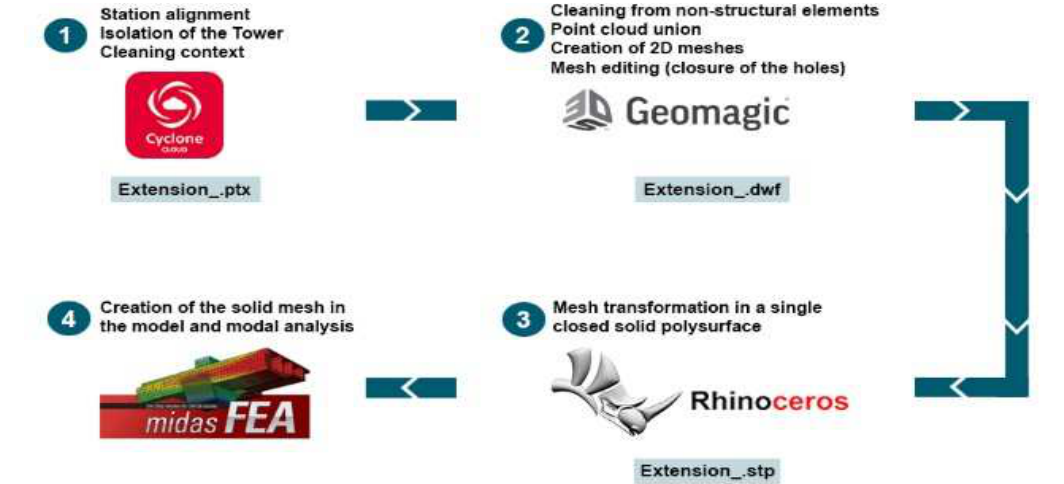
Figure 6 - Workflow from the point cloud to Midas FEA© software